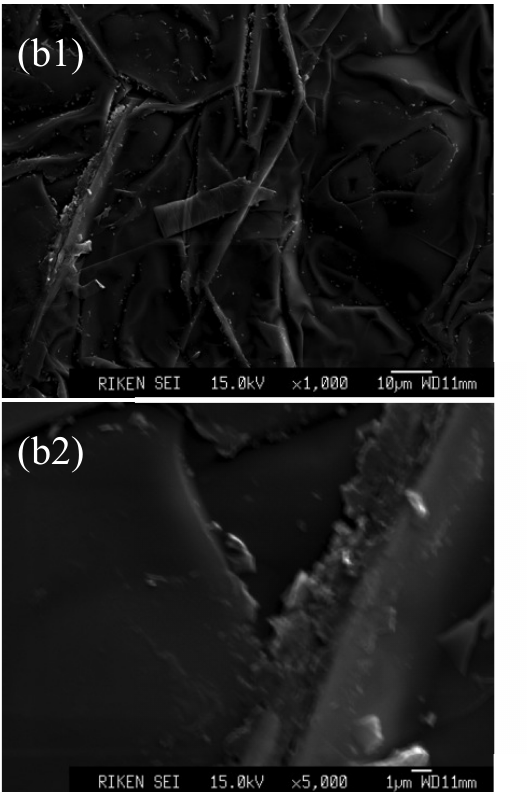
Fig. 2b. SEM images of the GS surface. (b1) and (b2): beam- irradiated part.